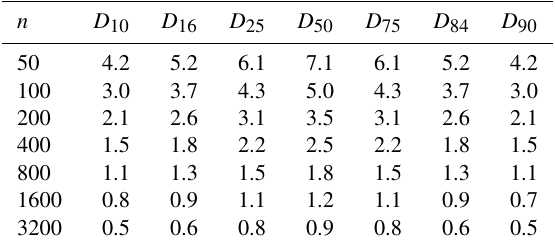
Table A1. Percentile standard deviations for various sample sizes ( n ) and percentiles ( D P